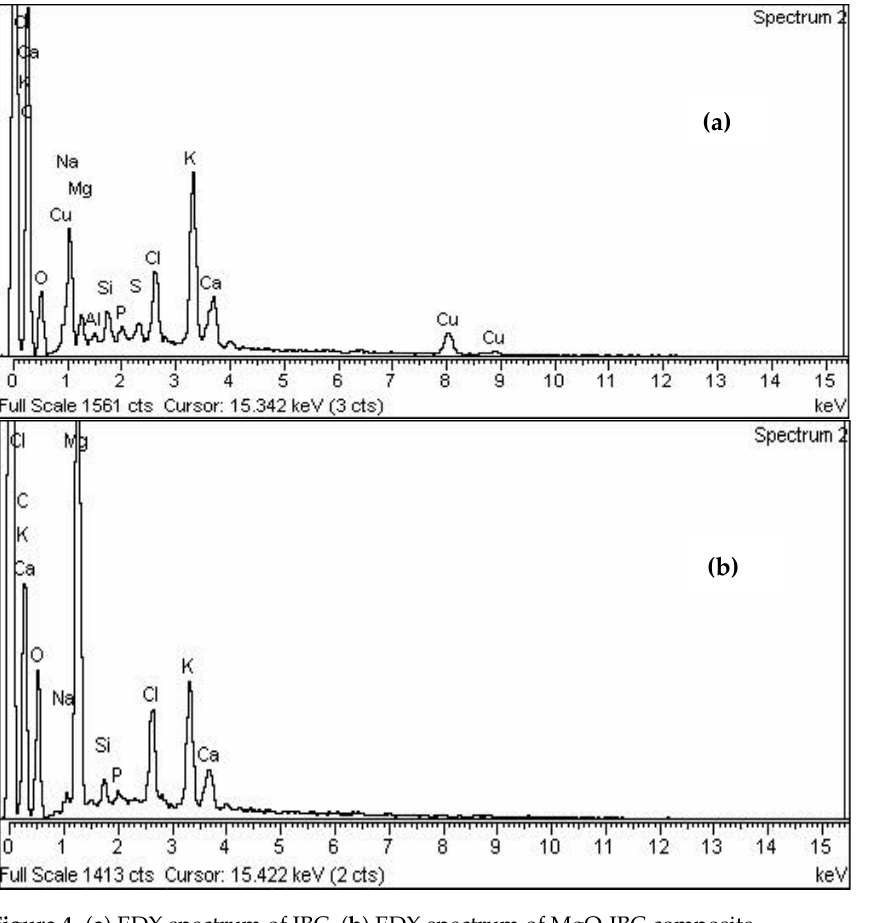
Figure 4. ( a ) EDX spectrum of IBC, ( b ) EDX spectrum of MgO-IBC composite.